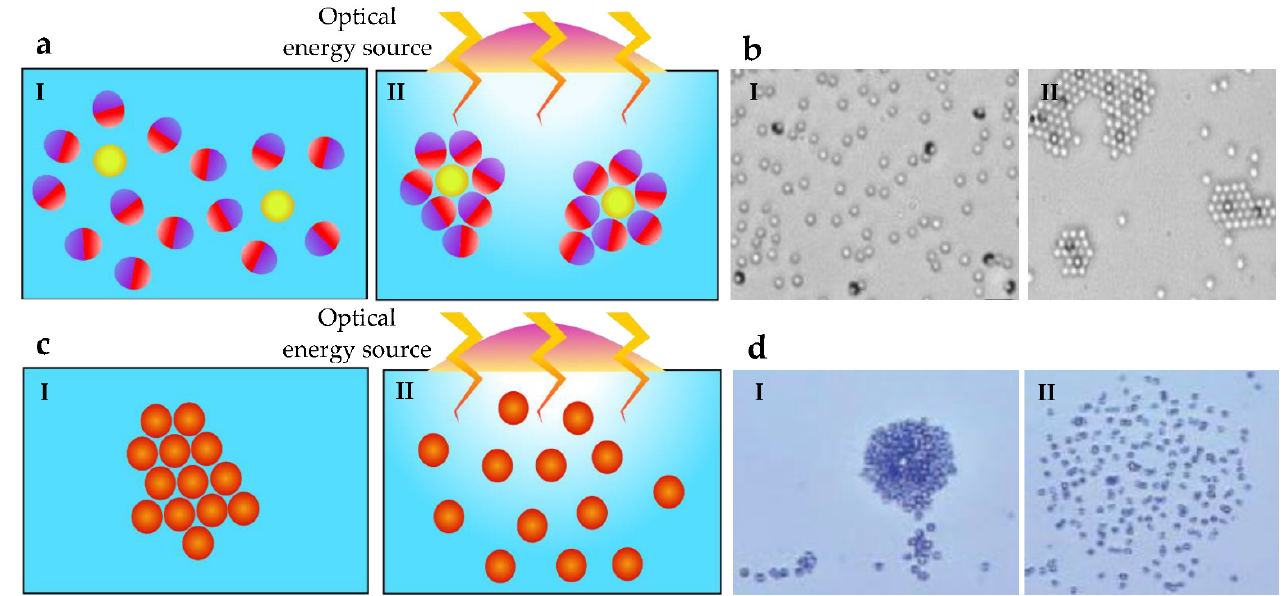
Figure 4. Shape formation techniques using optical methods: ( a ) In the presence of a light field, microparticles aggregate as a photochemical reaction. When the field is removed, particles move away from each other. ( b ) Representative example of TiO 2 active particles forming clusters under UV actuation. Reversible collectives disperse as a result of Brownian diffusion. Reproduced with permission from [54]; published by John Wiley and Sons. ( c ) In the absence of a light field, mi- croparticles aggregate; however, when a light field is applied, particles disperse from each other. ( d ) Representative example of colloids gathering around TiO 2 active particles. Neighboring particles move away from each other under UV actuation. Reproduced with permission from [83]; published by John Wiley and